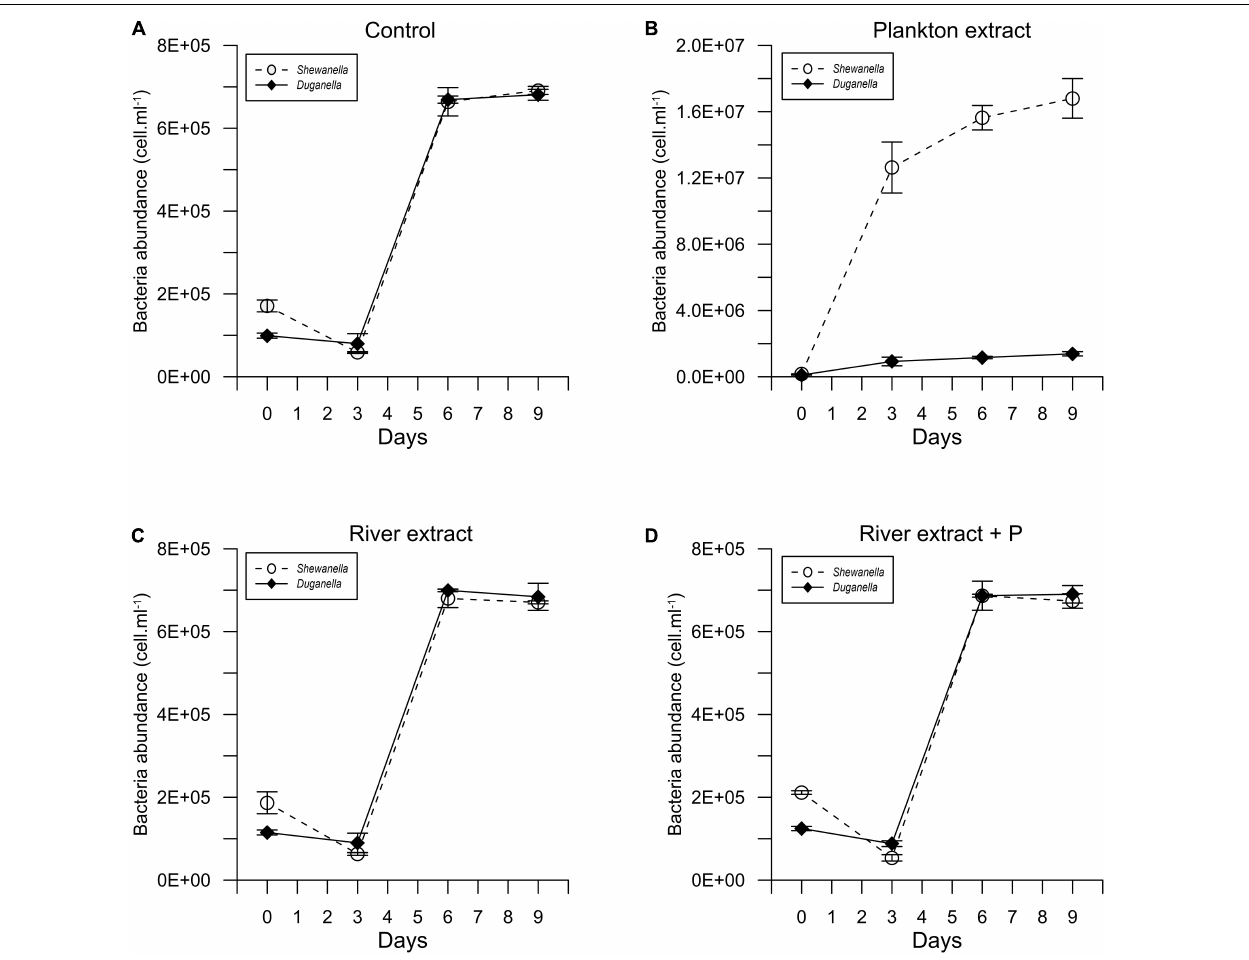
FIGURE 1 | Temporal variation of the abundance of Shewanella and Duganella in the (A) control, (B) plankton extract, (C) river extract, and (D) river extract + P supplemented microcosms. Data points show average values, and error bars denote standard deviation.